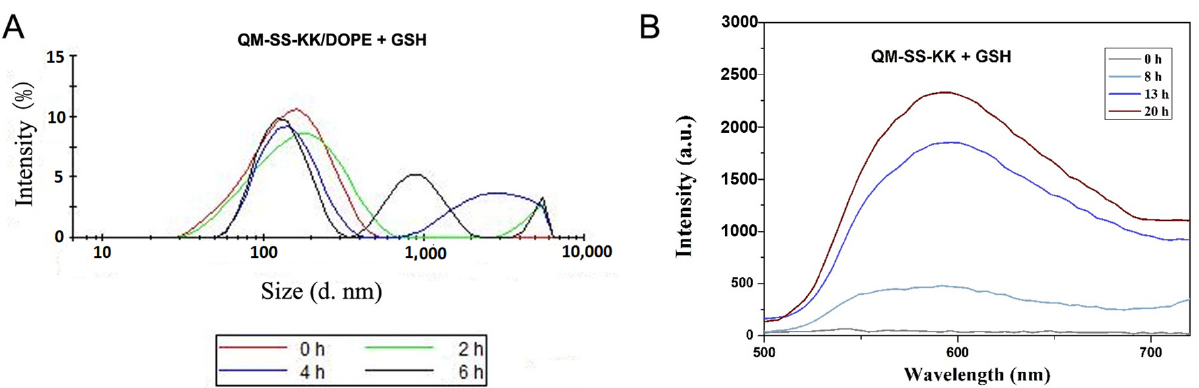
Figure 4. DLS assay of QM-SS-KK/DOPE ( A ) and fluorescence assay of QM-SS-KK ( B ) in the pres- ence of 10 mM of GSH after different incubation periods. of 10 mM of GSH after different incubation